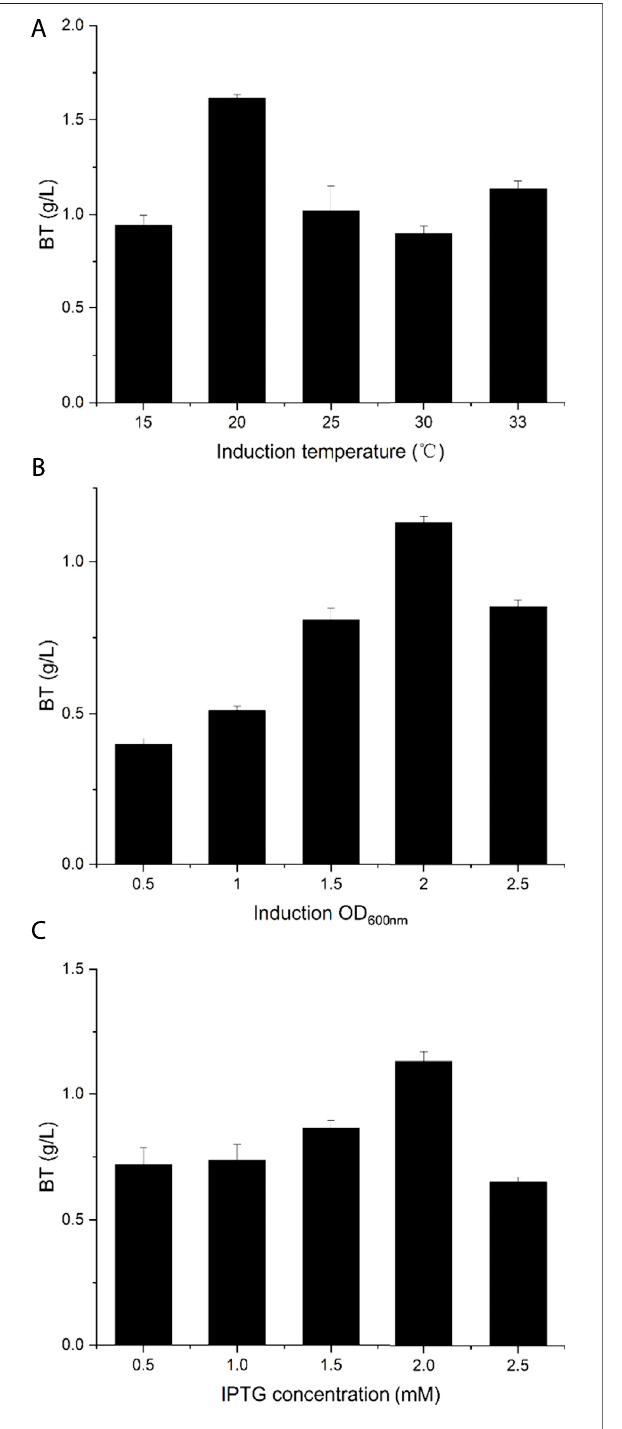
FIGURE 5 | Optimizing the fermentation conditions to produce BT. (A) Theoptimum inductiontemperature. (B) Theoptimum inductionOD 600nm . (C) The optimum IPTG concentration. The original fermentation conditions: induction temperature was 33 ° C; induction OD 600nm was 2; IPTG concentration was 2 mM. Each experiment only changes a single variable. Error bars represent SD ( n = 3).